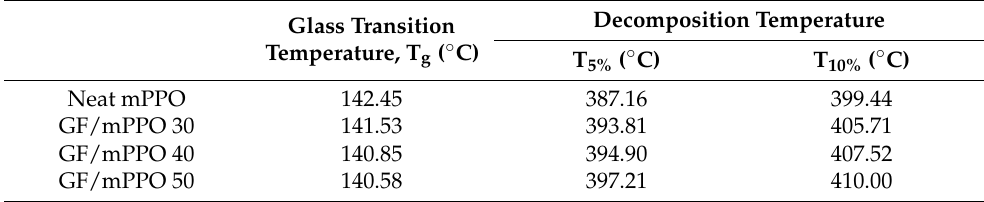
Figure 7. The 2nd heating curves of neat mPPO and GF/mPPO composites. Table 4. Thermal analysis results of neat mPPO and GF/mPPO composites. Table 4. Thermal analysis results of neat mPPO and GF/mPPO